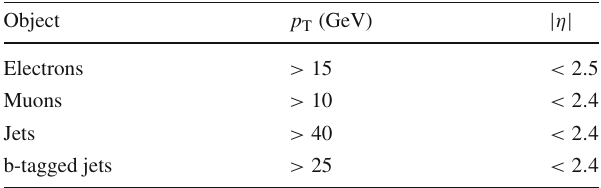
Table 1 Transverse momentum and pseudorapidity requirements for leptons and jets. Note that the p T thresholds to count jets and b-tagged jets are different; the jet multiplicity N jets includes b-tagged jets if their